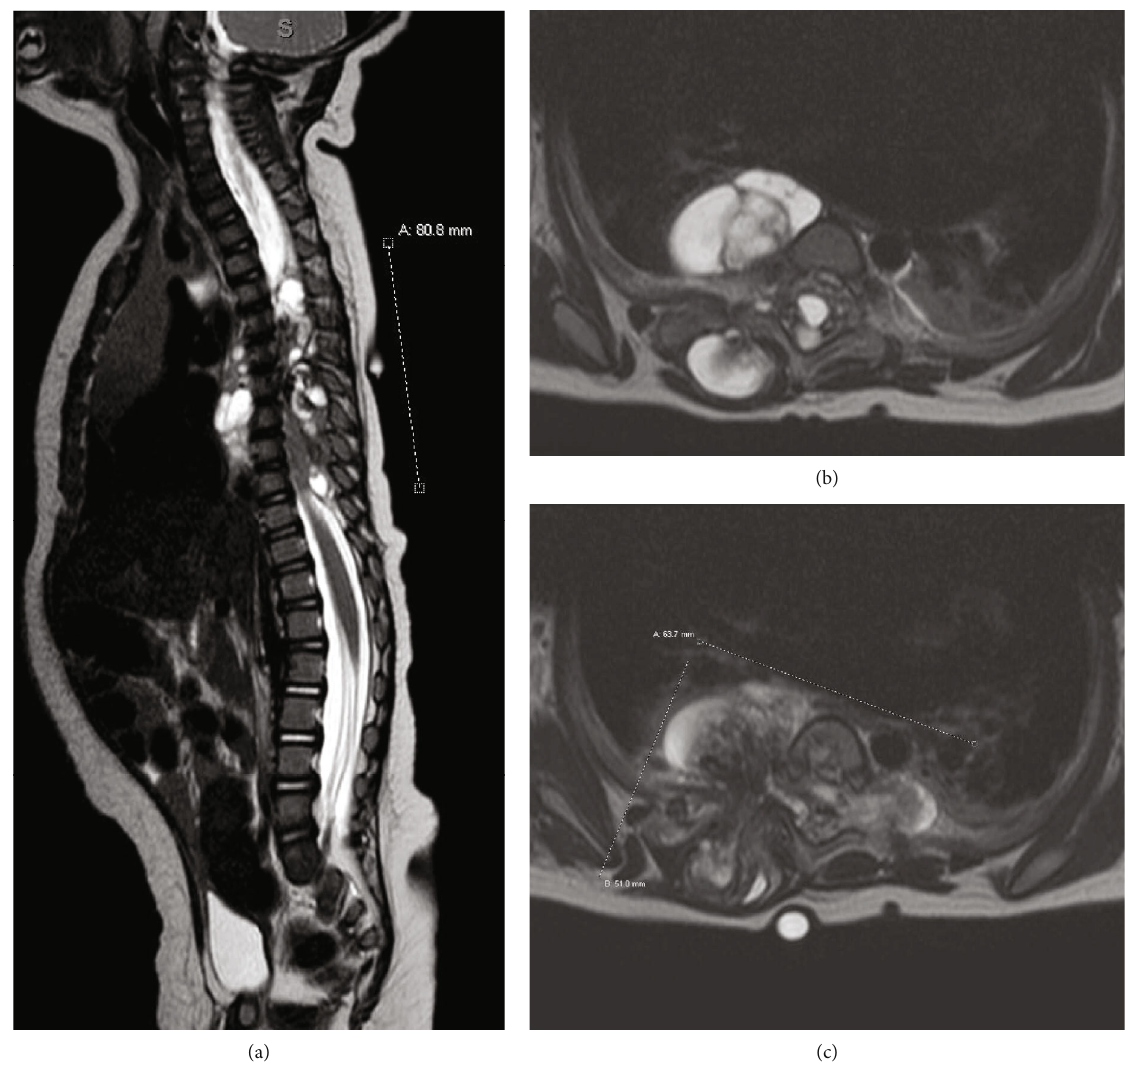
Figure 2: (a) Sagittal T2-weighted MR image showing multilobulated, partially cystic, trans-spatial heterogenous mass extending cranially to T3 and caudally to T10 with soft tissue extension anteriorly into the dorsal aspect of the intrathoracic cavity. (b, c) Axial T2-weight MR image further demonstrating the mass centered at T5-6 paravertebral space extending anteriorly into the dorsal aspect of the intrathoracic cavity, into the right dorsal paraspinal soft tissue/musculature, and into the spinal canal with severe displacement of the cord and resultant spinal